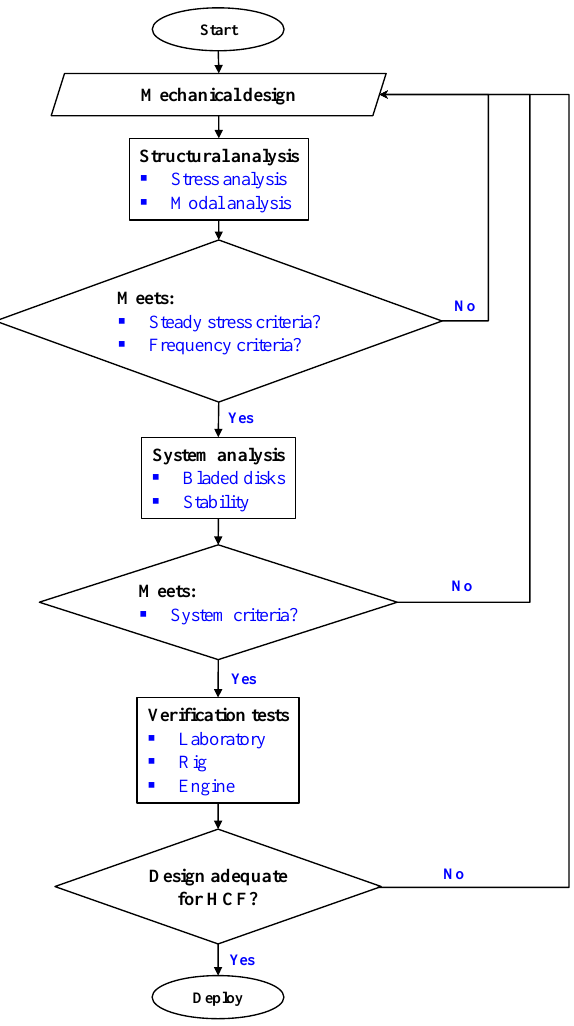
Figure 1. A generic procedure for HCF design and verification.